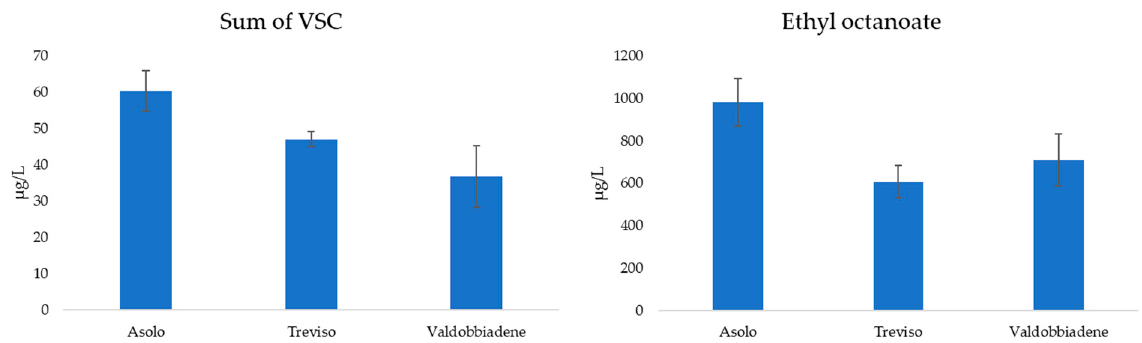
Figure 1. Concentration of the sum of VSC and ethyl octanoate in wines from Asolo, Treviso and Valdobbiadene.